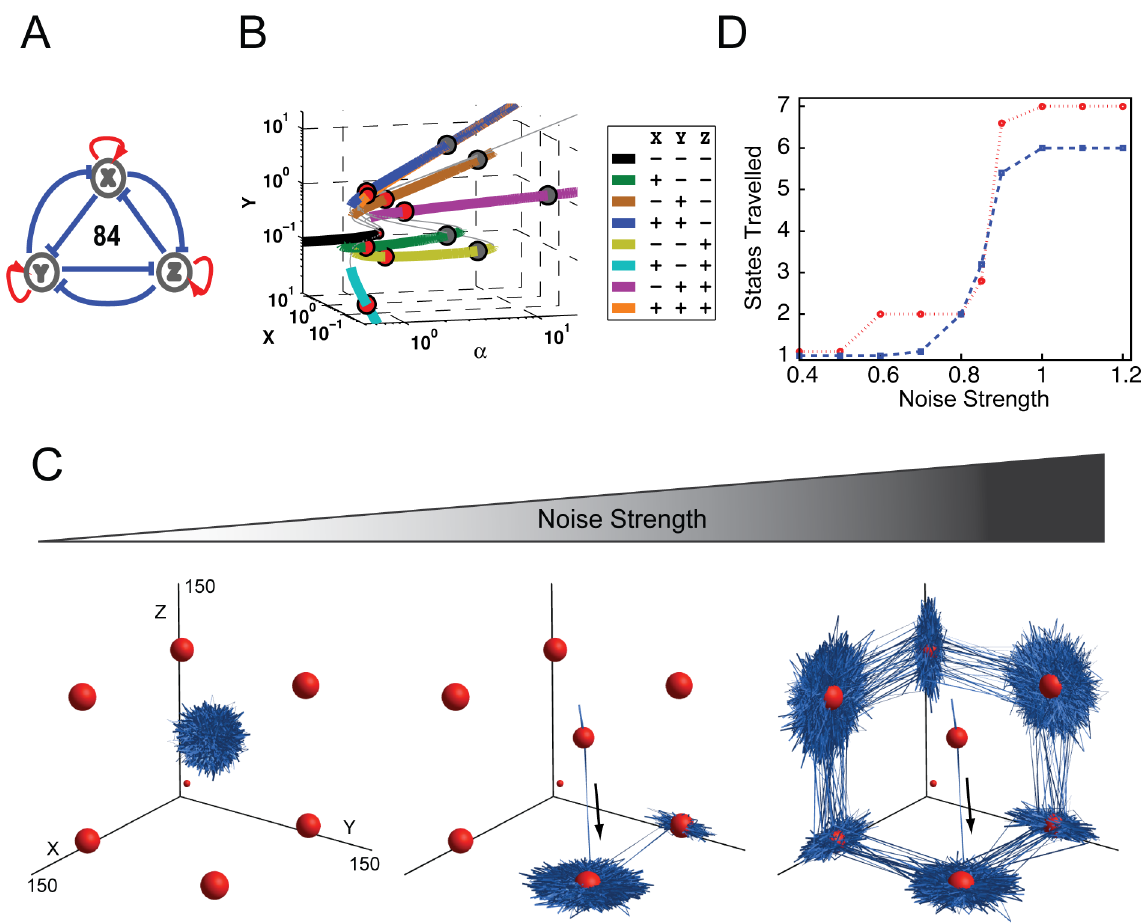
Figure 3. Bifurcation and Stochastic Analysis of Network 84. (A) The topology of Network 84 was predicted to have the highest probability for multistability. (B) The bifurcation diagram of Network 84 plots transcription factor concentrations of X and Y at each SSS against a , the self- activation strength. The mutual inhibition parameters are also set equal and referred to as b . Here b is set to 0.1 and a is used as the bifurcation parameter ranging between .01 and 100. By including both stable (colored) and unstable (grey) steady states we can see that as a increases the SSS move to higher concentrations, approximately at the same rate as the increase in a . SSS are color coded and listed in the legend to distinguish different SSS, where ‘ + ’ indicates the gene is ‘ON’ and ‘-’ means ‘OFF’. Spheres are also attached to each SSS at a =1 (red) and a =5 (gray), sphere size correlates with the size of the spectral radius, a measure of SSS stability. (C) Simulations of noise-induced state transitioning in Network 84 under different levels of noise. Simulations were performed with auto-regulation equal to 1 and mutual inhibition equal to 0.1, with noise levels of 0.5, 0.85, and 1 from left to right. The locations of the deterministically calculated states are indicated with red spheres, with their size correlated to their spectral radius. The blue ribbons indicate the temporal trajectories of the simulations. The black arrows indicate initial direction of state transitions. Potential cloud shape for each SSS is illustrated in Figure S6A. (D) The number of states traveled in the stochastic simulations plotted versus noise strength. The red line represents simulations that were initiated from the all-ON state, and the blue line represents simulations that were initiated from the origin.